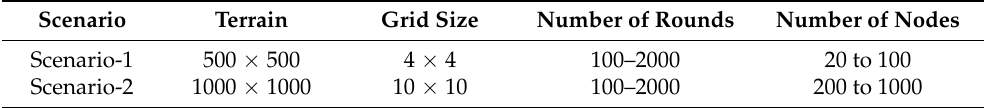
Table 6. Experimental scenarios and specifications.